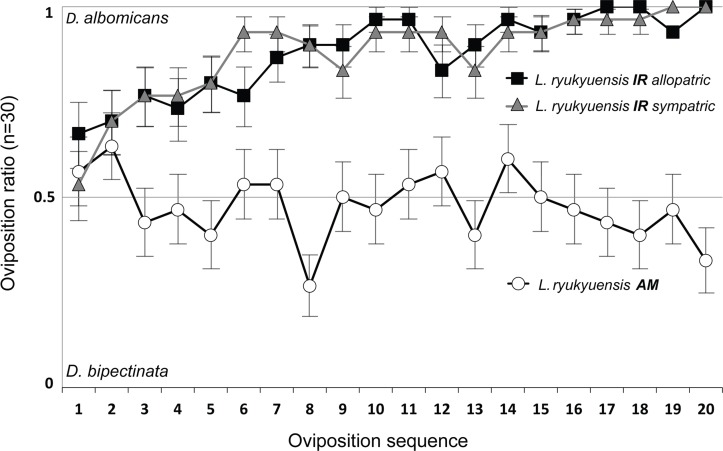
Oviposition sequences of AM and IR strains of L. ryukyuensis.Marks indicate the departure from the 0.5 line which represents the same probability of D. albomicans or D. bipectinata larvae being chosen for oviposition. Each mark represents the ratio derived from the observation of 30 wasps. Numbers 1 and 20 on the horizontal axis represent the first and the last observed oviposition, respectively. (white circles) AM wasps ovipositing in NH fly strains, (black squares) IR wasps ovipositing in NH fly strains, (gray triangles) IR wasps ovipositing in IR fly strains.